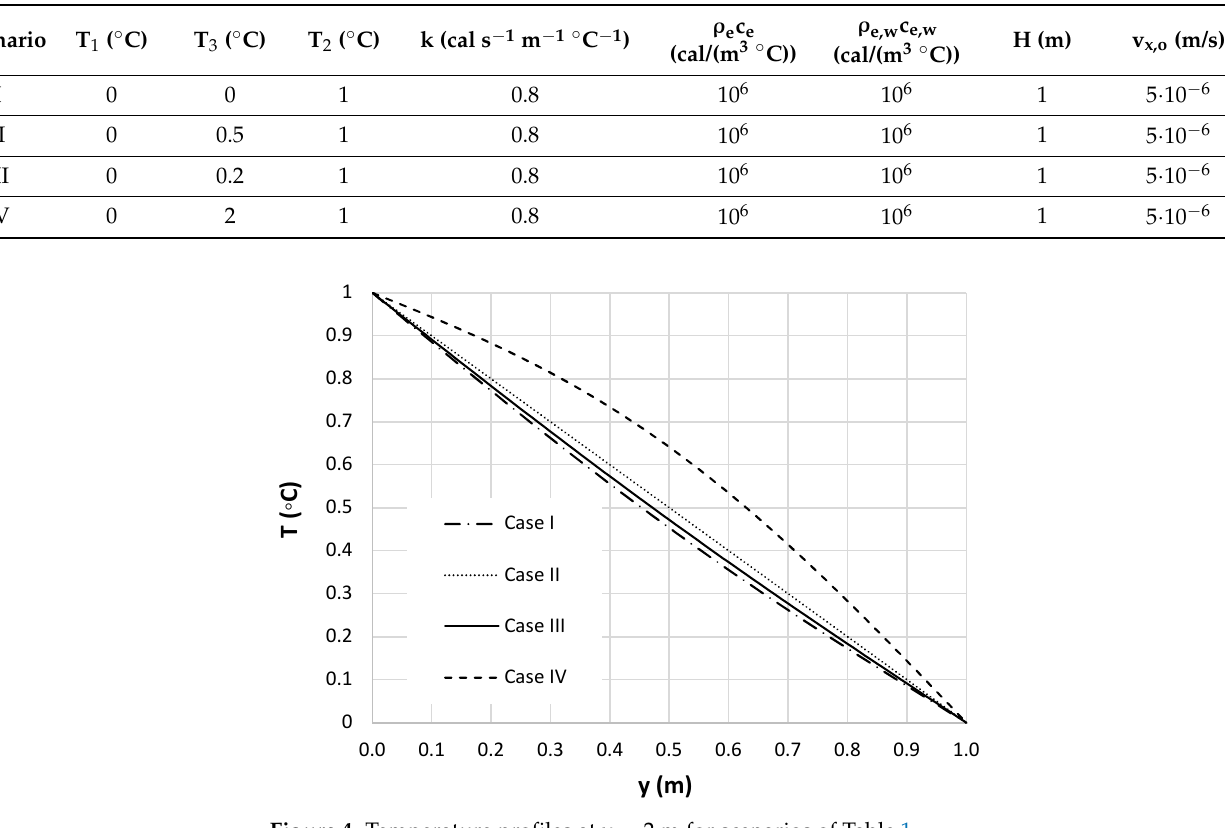
Figure 3. Patterns of the steady-state solution for scenarios of Table 1. Scenarios I and II ( up ) and Scenarios III and IV ( down ). Table 1. Parameters of typical scenarios whose patterns are shown in Figure 3.